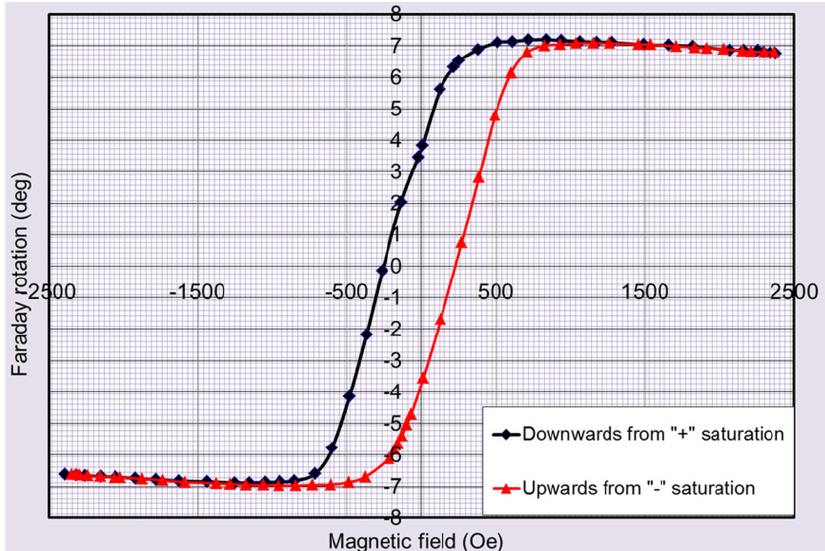
Figure 7. Magnetic hysteresis loop (measured by tracing the Faraday rotation angle at 532